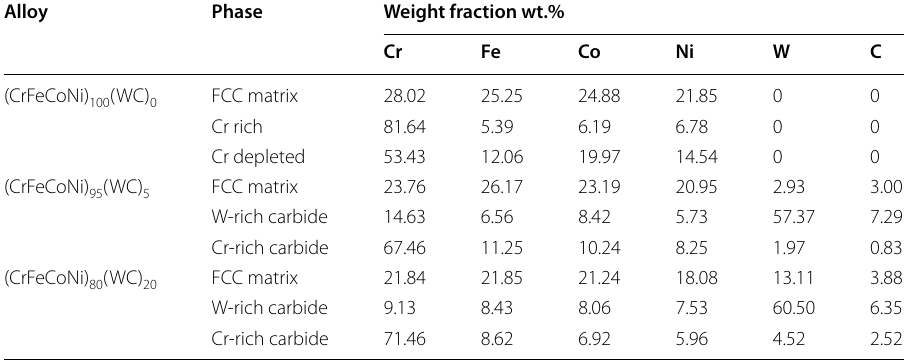
Table 3 Chemical compositions of different phases of (CrFeCoNi) and EDS analysis